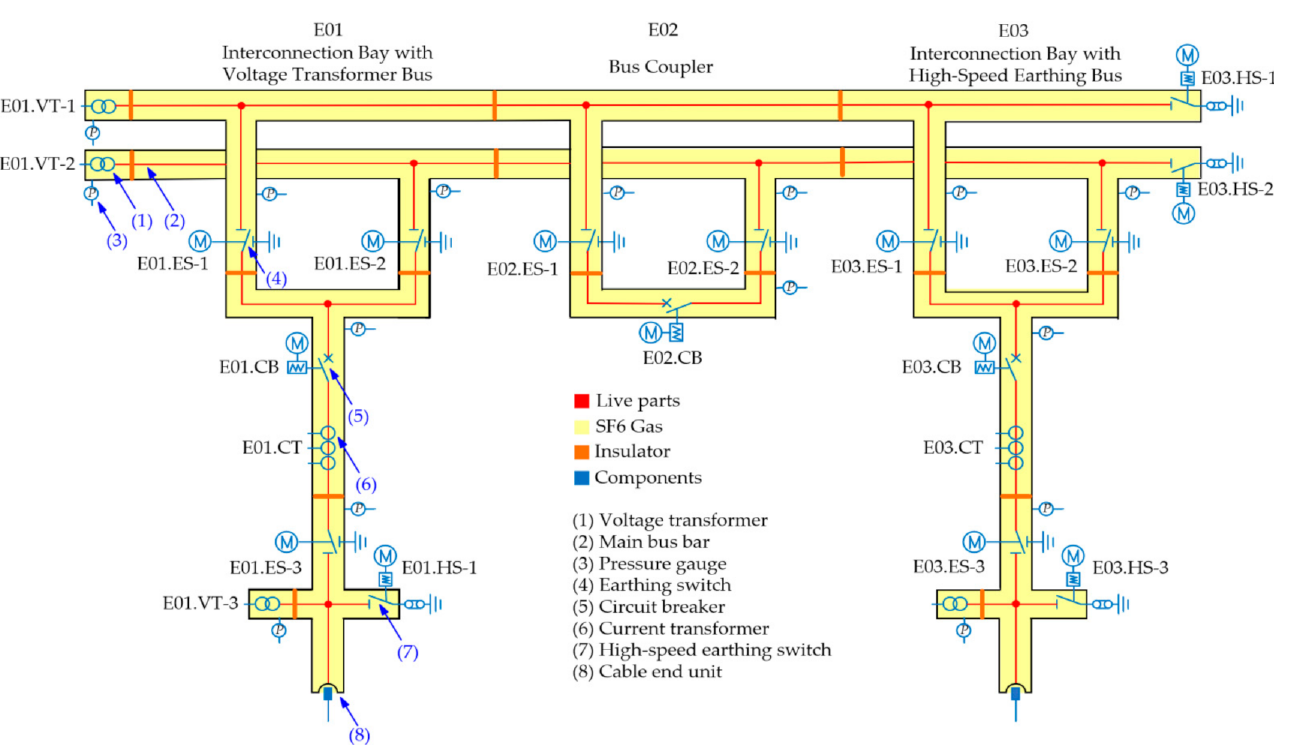
Figure 1. GIS in double busbar arrangement diagram.